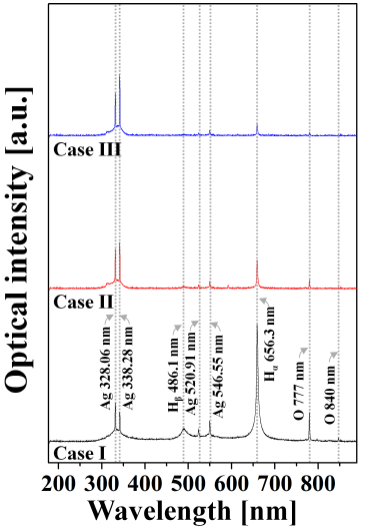
Figure 4. Optical emission spectra (OES) for plasma generated by three bubble formations shown in Figure 2 with exposure time of 200 ms.